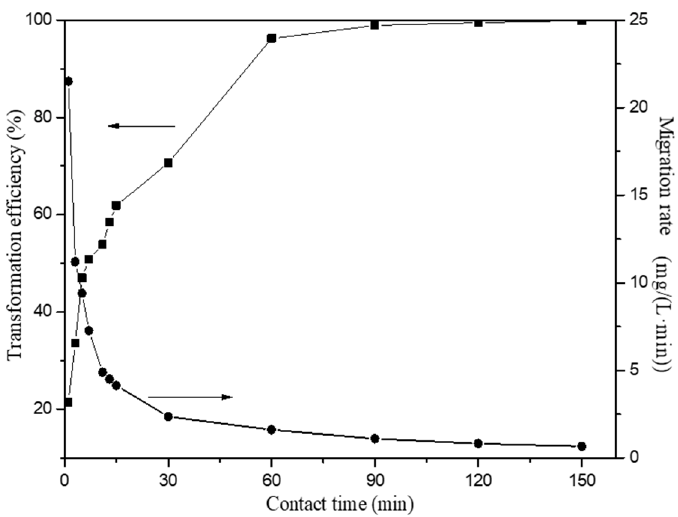
Figure 6. Effect of reaction time on the Fe( Ⅲ ) transformation in the presence of HAP.